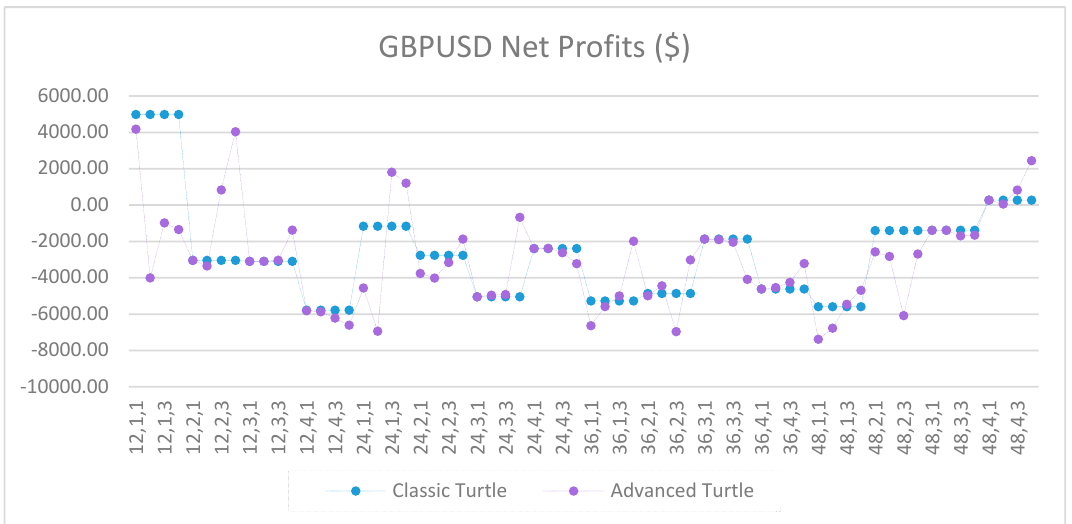
Figure A37. Net profits of GBPUSD between the classic and the advanced Turtle systems for every combination of N, X, Y for the slow parameters (80, 160).